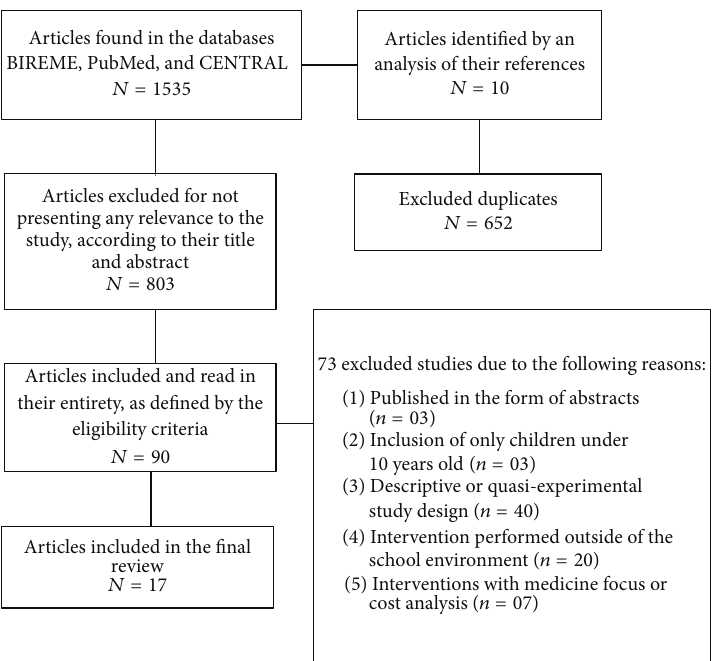
Figure 1: Flowchart of the selection of studies included for a systematic review of the